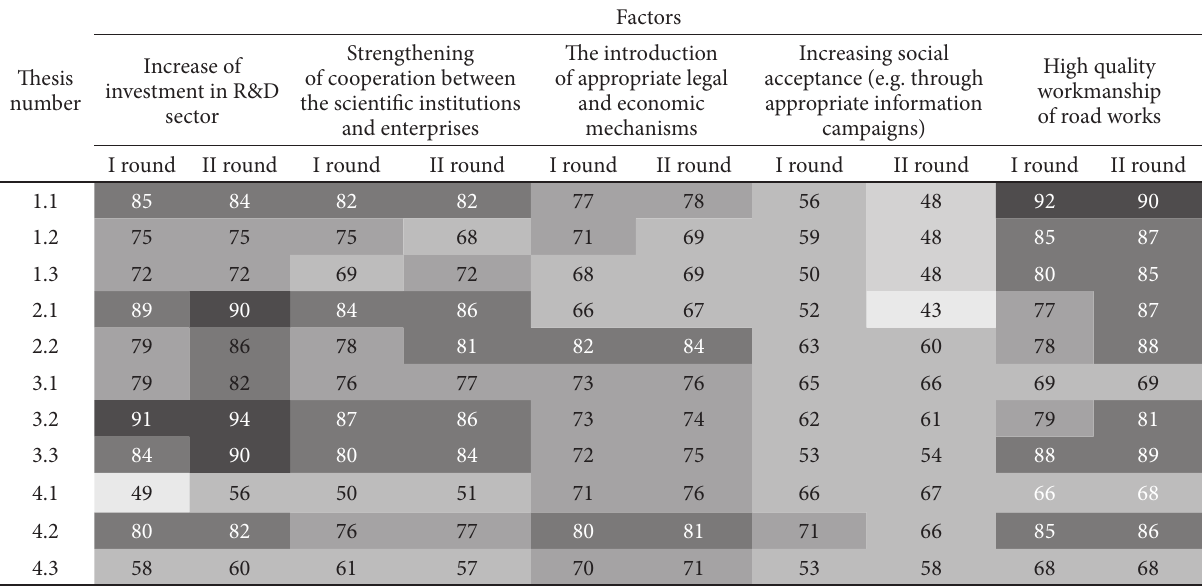
Table 2. Power of factors supporting the implementation of the Delphi theses